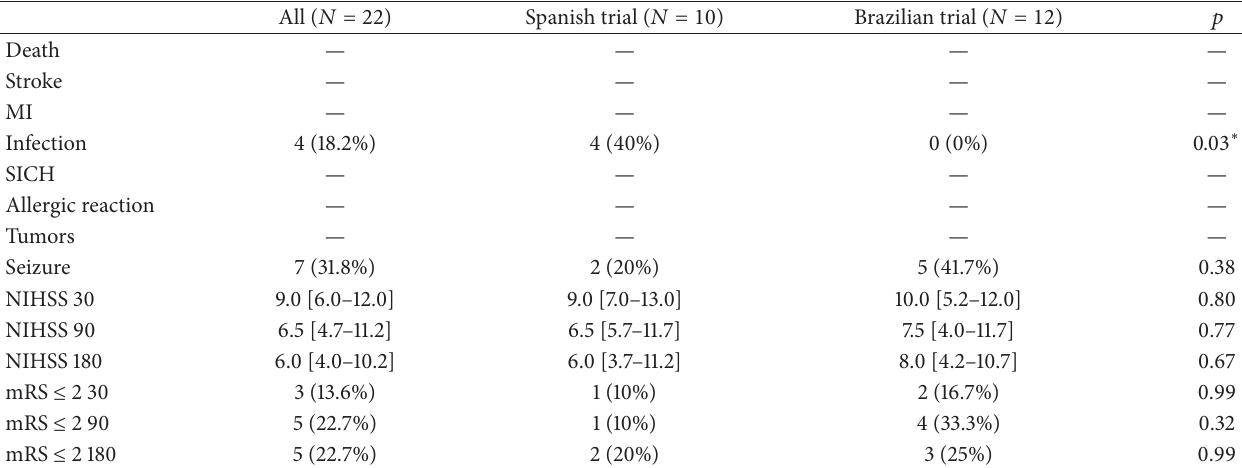
Table 2: Follow-up of patients treated with